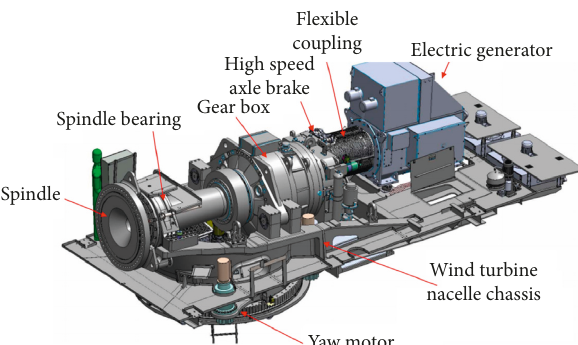
Figure 6: Motor drive system in pitch actuator.